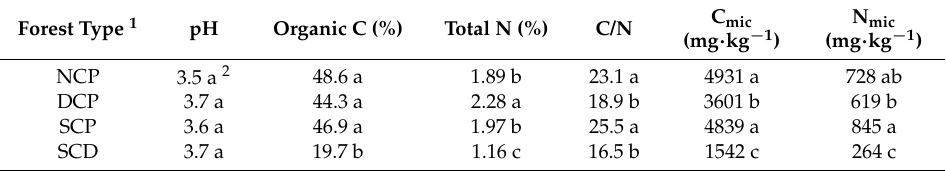
Table 1. Soil chemical properties and microbial biomass under natural and managed forest.